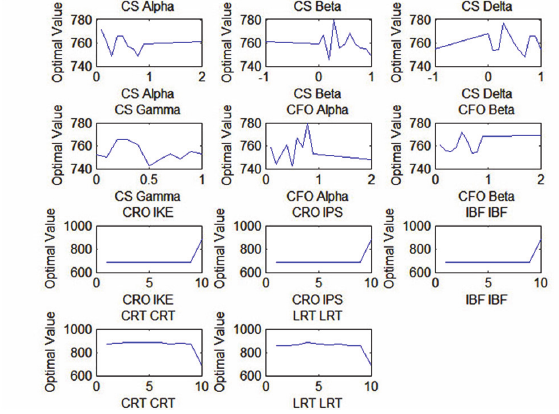
Fig. 3. Parameter tuning for the